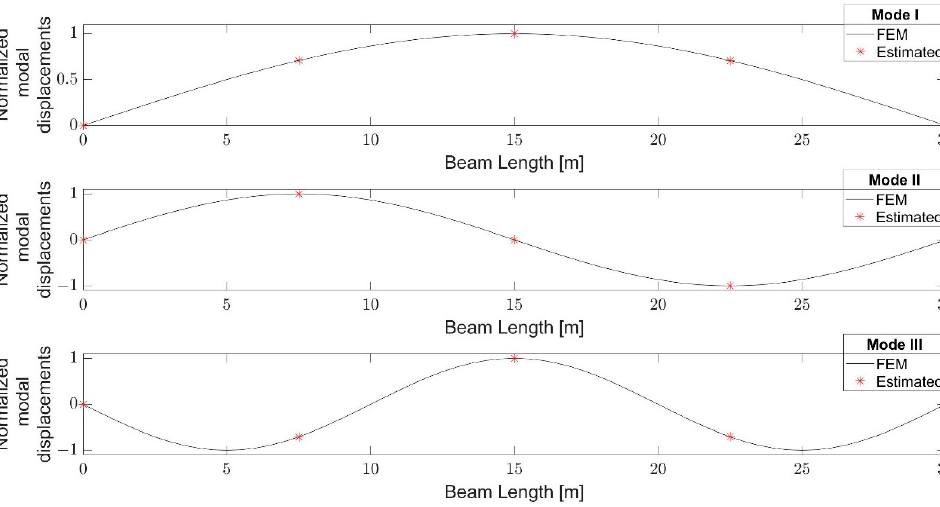
Figure 5. Simulated road roughness profiles corresponding to Class A, B, and C. The traffic induced vibration response of the bridge has been simulated for the three different road profiles and increasing noise levels (10%, 20%, and 30%) in order to assess the performance of output-only modal identification from indirect measurements characterized by different signal-to-noise ratio. Gaussian white noise was therefore added to the simulated time series to account for the effect of measurement noise. While the results were consistent independently of the road profile, the presence of noise limited the